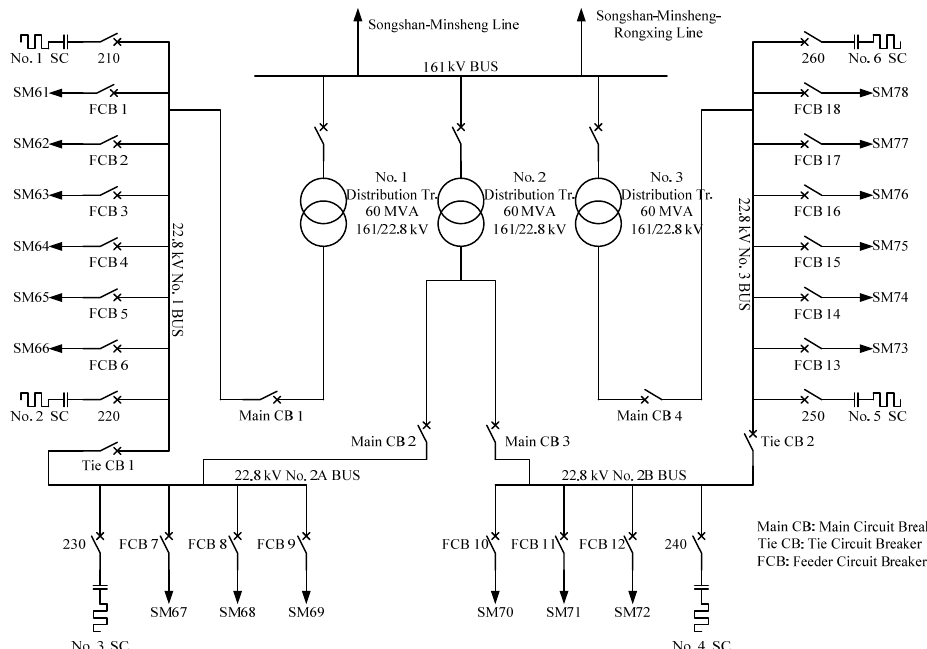
Figure 5. One-line diagram of Minsheng